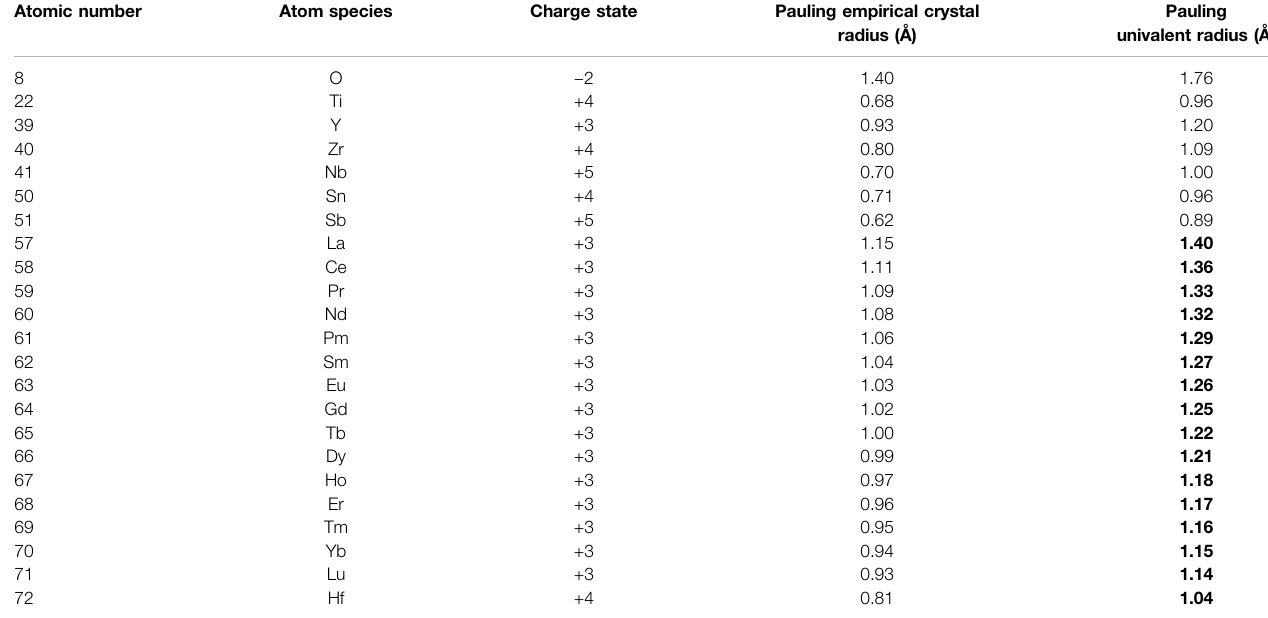
TABLE1| Summaryofthedifferentradiiusedinthisstudy.ThepreviouslyunreportedPaulingunivalentradiiwerecalculatedfromEqs13 – 8inPauling(1960)usingavalueof 12 for the Born exponent (corresponding to an electron con fi guration), in accordance with Table 13-2 in Pauling (1960). The Pauling empirical crystal radii are from References Pauling (1929), Pauling (1960), Galasso (1970), and Rohrer (2001). Entries in bold represent previously unreported data and were calculated for this study. Atomic